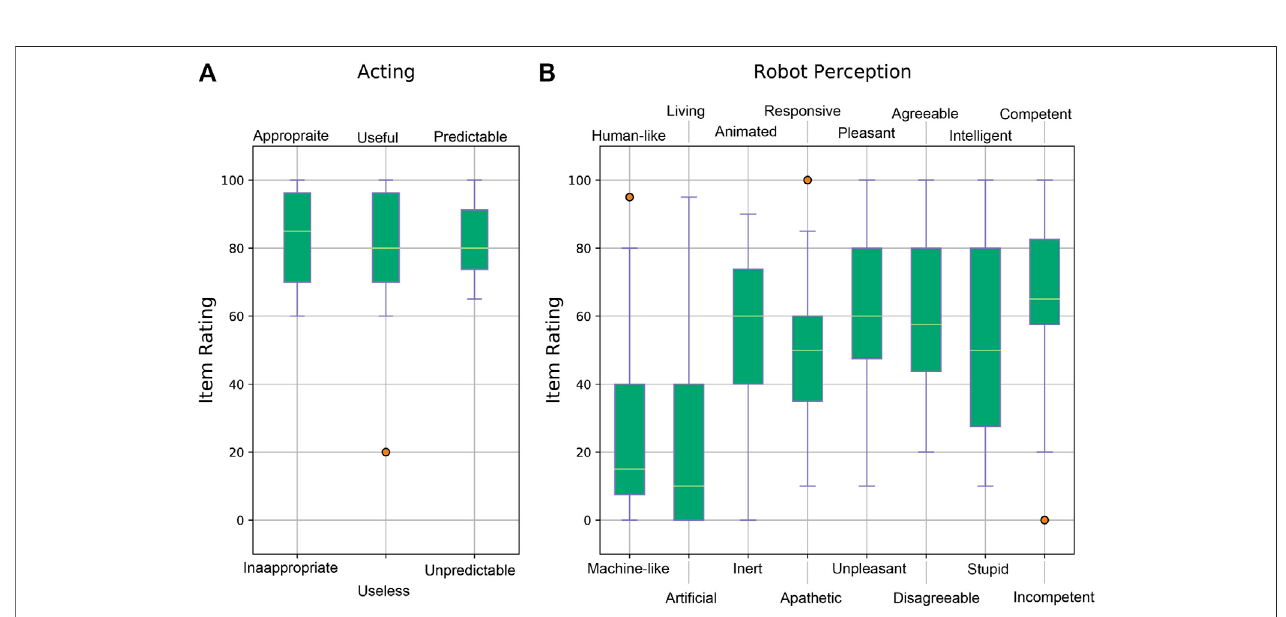
FIGURE 5 | Results of the PeRDITA questionnaire for the Acting and Robot Perception dimensions. (Panel A) shows the item ratings forming part of the Acting dimension, and (Panel B) shows the item ratings for the Robot Perception dimension.